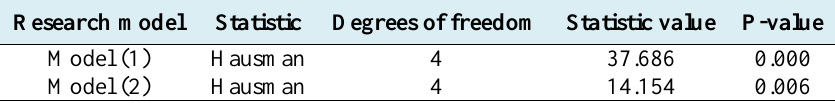
Table 18. The results of the Hausman test in the TSE